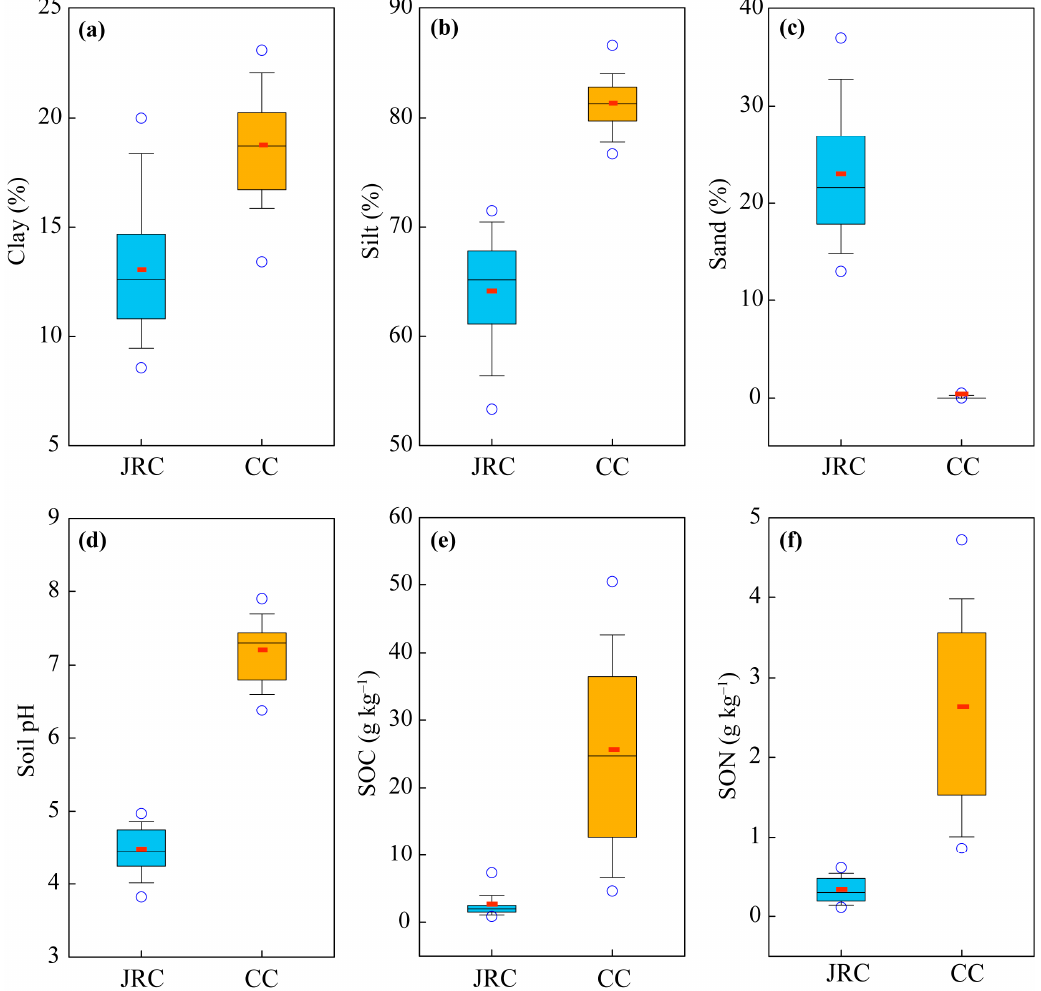
Figure 2. Soil properties, including ( a ) clay percent, ( b ) silt percent, ( c ) sand percent, ( d ) soil pH, ( e